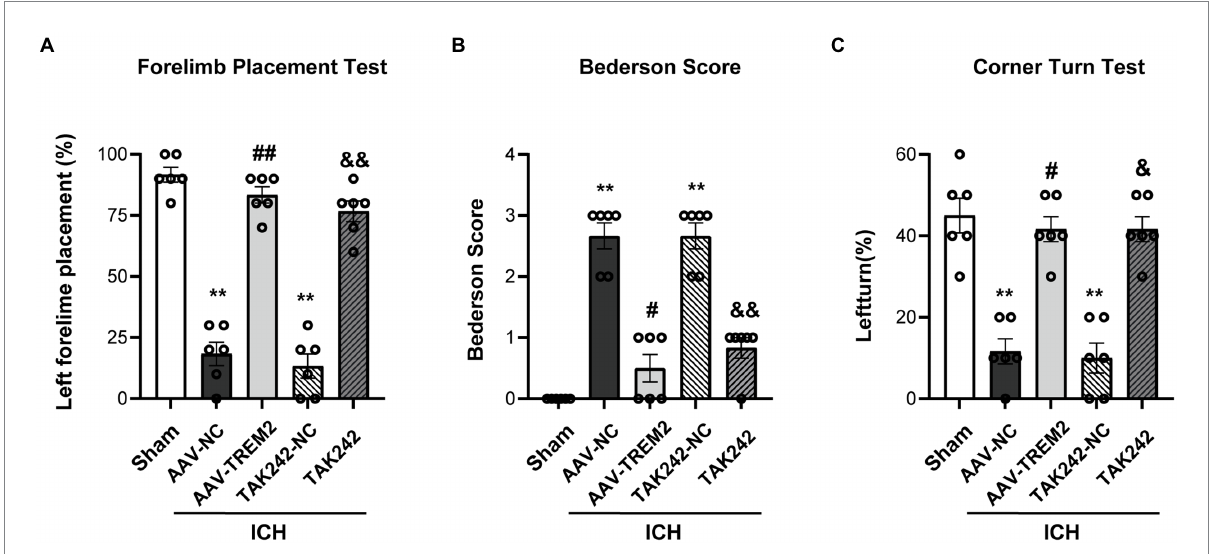
FIGURE 1 TREM2 overexpression and TLR4 antagonist TAK242 alleviated intracerebral hemorrhage-induced neurological dysfunction. (A) Forelimb placement test. (B) Bederson score. (C) Corner turn test. ** p < 0.01, vs. the sham group, # p < 0.05, ## p < 0.01, vs. the AAV-NC + ICH group, & p < 0.05, && p < 0.01, vs. the TAK242-NC + ICH group. ICH: intracerebral hemorrhage, AAV, Adeno-associated virus, LV, lentivirusl NC, negative controls. The data were represented as mean ± SEM. n = 6 per